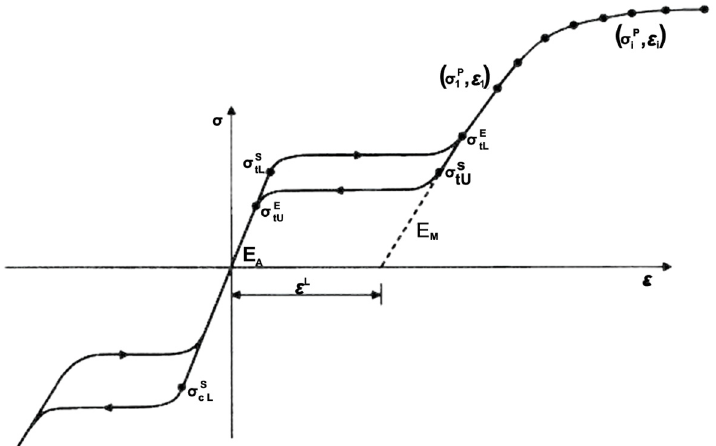
Figure 2. Nitinol stress ‐ strain curve and the corresponding data inputs for the ABAQUS UMAT